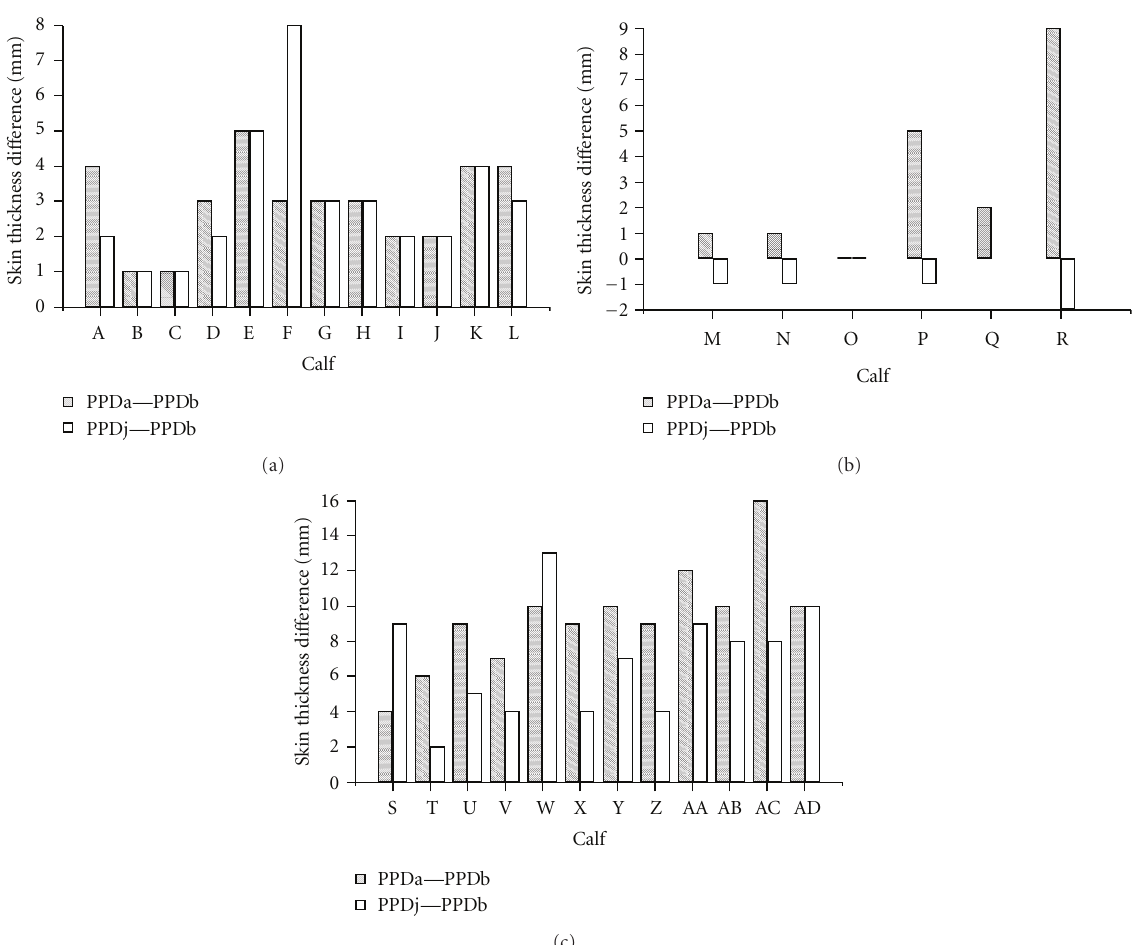
Figure 3: (a) Mean di ff erences in skin thickness of 12 calves exposed to Map. Measurements were made at 39 weeks postinfection using PPDa, PPDb, and PPDj tuberculins. (b) Mean di ff erences in skin thickness of 6 calves exposed to Maa. Measurements were made at 64 weeks postinfection using PPDa, PPDb, and PPDj tuberculins. (c) Mean di ff erences in skin thickness of 12 calves exposed to Maa.